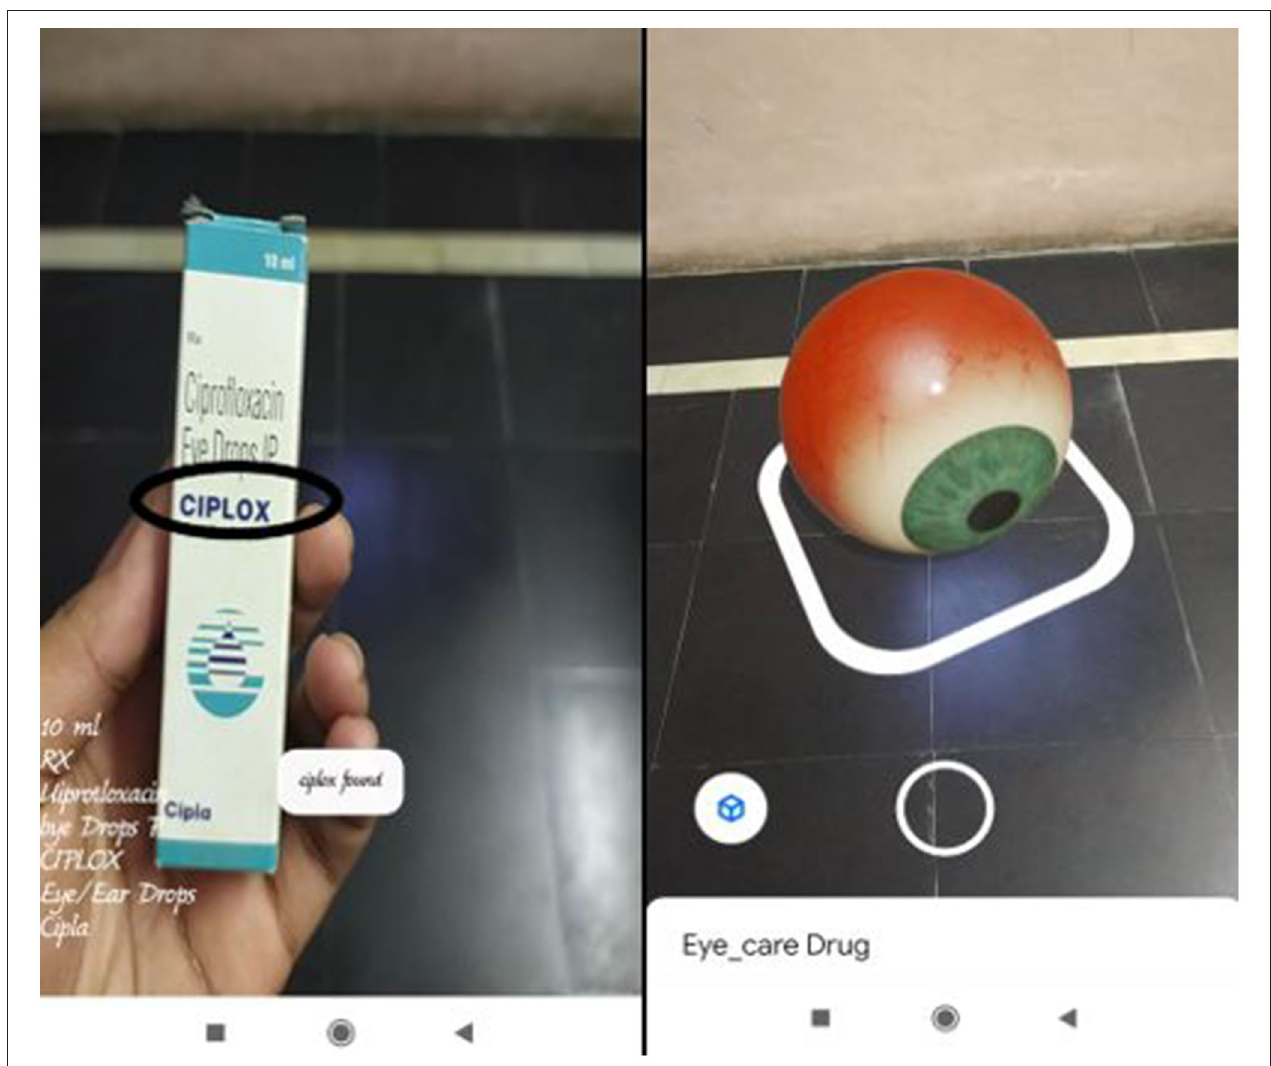
FIGURE 4 | Medicine name and AR-based eye